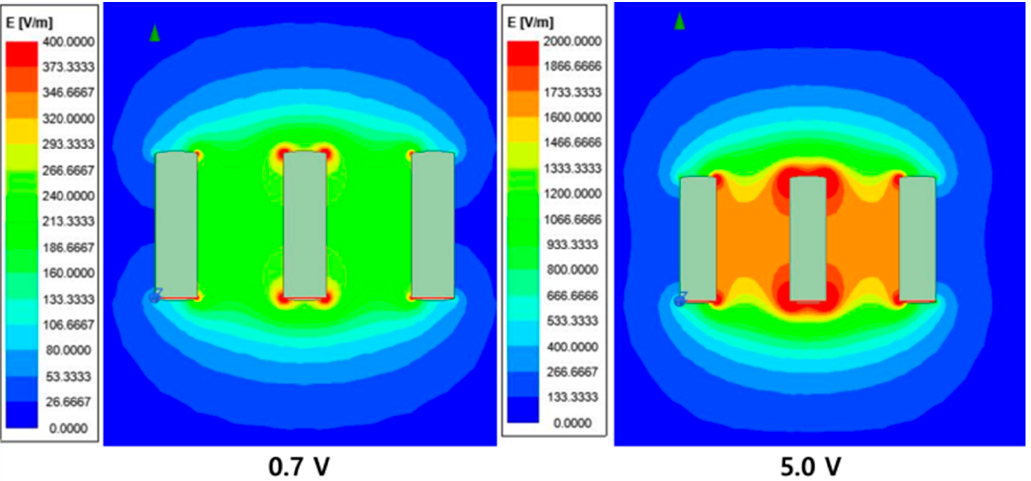
Figure 5. Contour plot of the estimated value of the electric field for the different voltage conditions.